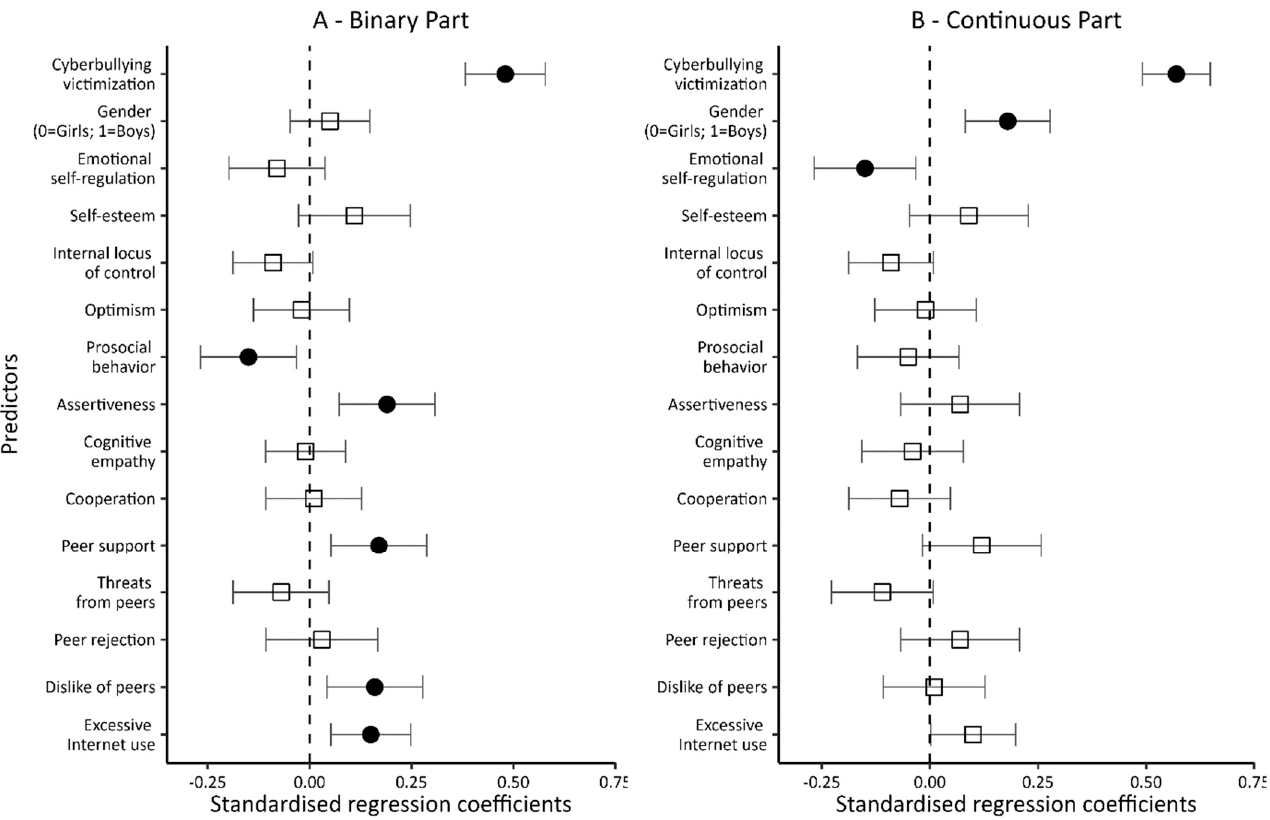
Figure 5. Model 3. Standardised regression coefficients with 95% confidence intervals. Note: Black circle-coefficient significant at 0.05; white square-coefficient insignificant ( p > 0.05); tails = standard errors.